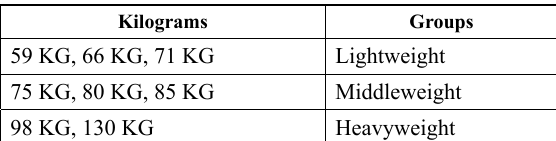
Table 1. Distribution of kilo groups